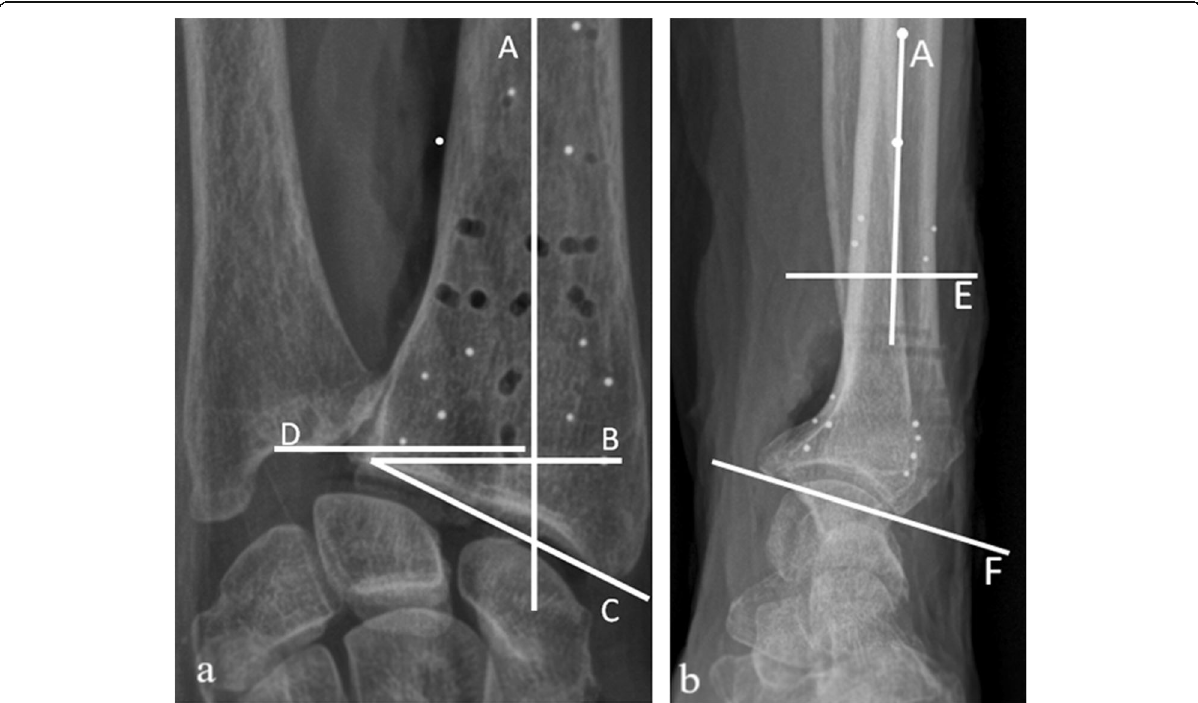
Fig. 4 Radiographic measurements. Posterior-anterior projection ( a ); lateral projection ( b ). Line A represents the longitudinal axes of the radius (in both planes), determined by connecting two points (more than 2 cm apart) in the centre of the radial shaft. Line B is drawn from the most distal ulnar palmar corner of the radial articular surface and is perpendicular to line A. Line C connects the most distal ulnar palmar corner of the radial articular surface to the most distal part of the radial styloid tip. Line D abuts the most distal point of the articular surface of the ulna; it is parallel to line B thus perpendicular to the longitudinal axis of the radius. Line E is drawn at a convenient level perpendicular to the central long axis of the radius. Line F connects the most distal dorsal and palmar margins of the radial articular surface. The ulnar variance is defined as the length of the ulna relative to the radius, i.e. , the distance (mm) between lines D and B. The radial inclination is the inclination of the distal radial articular surface in the coronal plane, i.e. , the angle between lines B and C. Tilt describes the angulation of the distal radial articular surface in the sagittal plane, i.e. , the angle between lines E and F